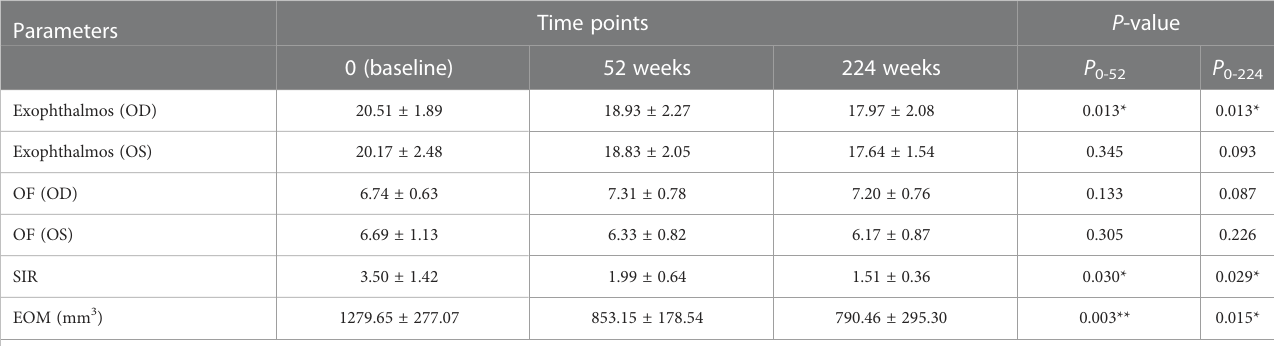
The numeric data are reported as the mean ± standard deviation. OD, right eye; OS, left eye; OF, the thickness of orbital fat; EOM, the volume of extraocular muscle with maximum signal intensity. SIR, the highest signal intensity ratio of extraocular muscle